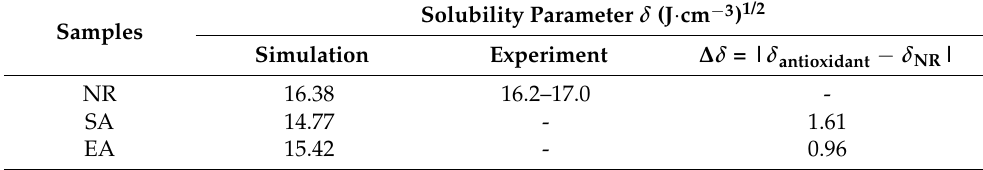
Table 3. Solubility parameters for SA, EA, and NR.